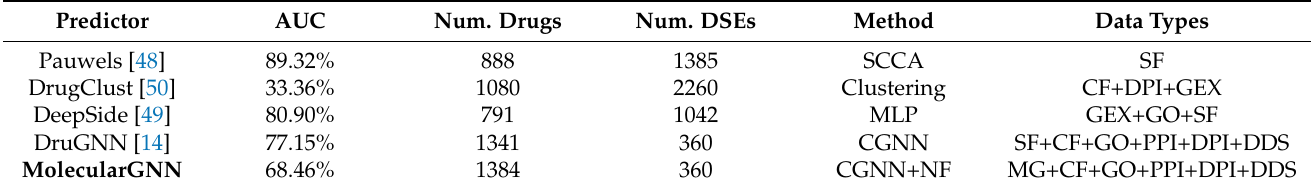
Table 4. Comparison of data and methodology for each predictor. NF stands for neural finger- prints, SF for structural fingerprints, MG for molecular graphs, GO for Gene Ontology data, CF for chemical features, DPI for drug–protein interactions, DDS for drug–drug similarity, PPI for protein–protein